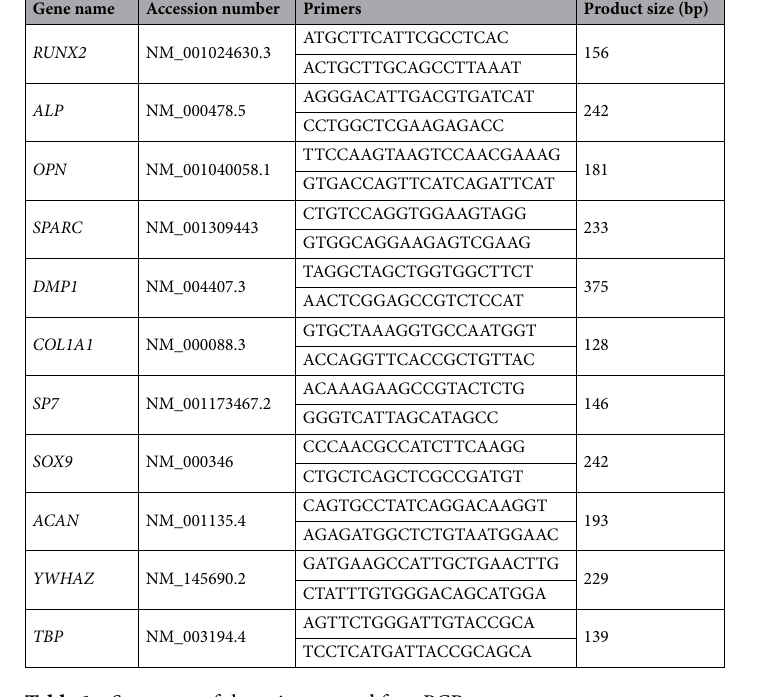
Table 1. All samples were analyzed in duplicate using the LightCycler 480 Software release 1.5.0 SP4 (Roche Diagnos- tics). mRNA levels of the target genes were normalized to the housekeeping gene YWHAZ and TBP using the advanced relative quantification analysis. Gene expression analysis in chondrocytes was performed with Human Chondrocytes-articular Total RNA (Sanbio) after cDNA synthesis. Mineralization assay.